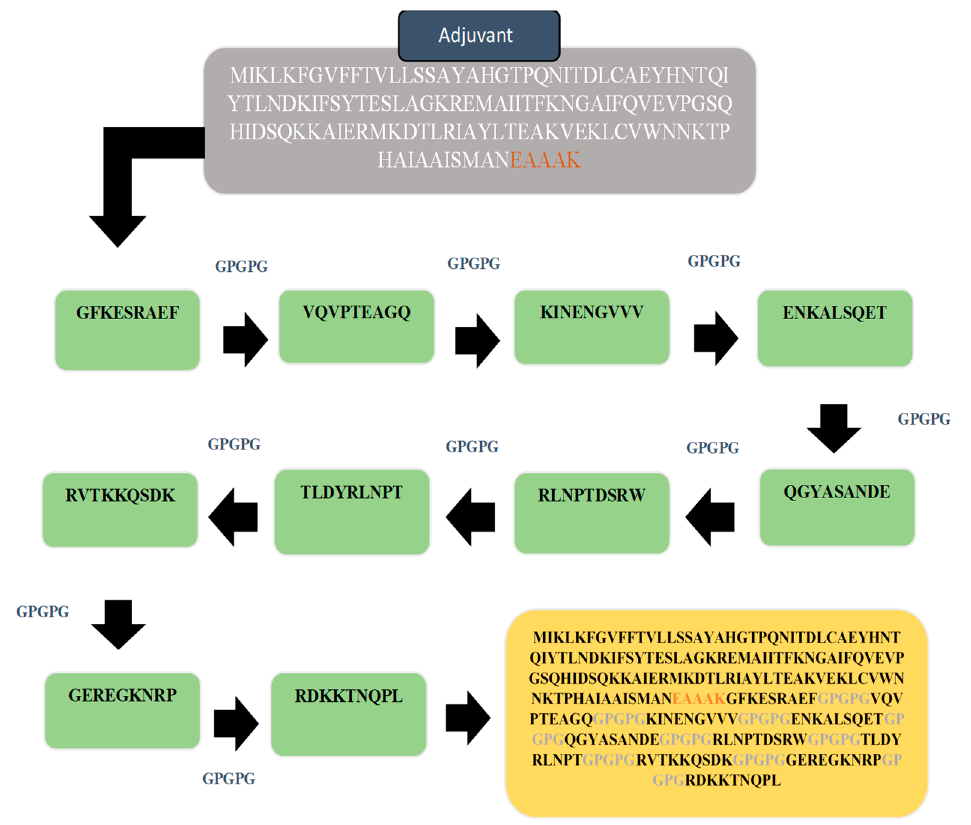
Figure 4. Schematic diagram of 264 amino acid long vaccine construct sequence. The selected epitopes are represented in green color boxes, GPGPG linkers for linking epitopes with each other while EAAAK linker to join the designed vaccine construct with cholera toxin B subunit adjuvant as shown in the purple color box.